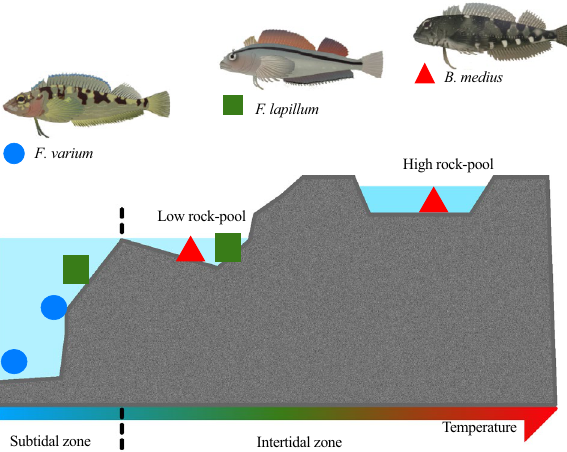
Figure 1. Triplefin species used in this study and their respective distributions. Bellapiscis medius is a high intertidal species that experiences a wide range of temperatures daily. Forsterygion lapillum is a shallow subtidal species that occurs at depths around 5–10 m and experiences a narrower temperature window than B. medius . Forsterygion varium is a deeper sub-tidal species found at depths of 8–20 m and experiences the narrowest temperature range of all three species. Temperatures in these rock pools vary with the tides and can peak in the summer months at ~ 30 °C (McArley et al., 2018; 2019). Triplefin images courtesy of Vivian Ward & Kendall